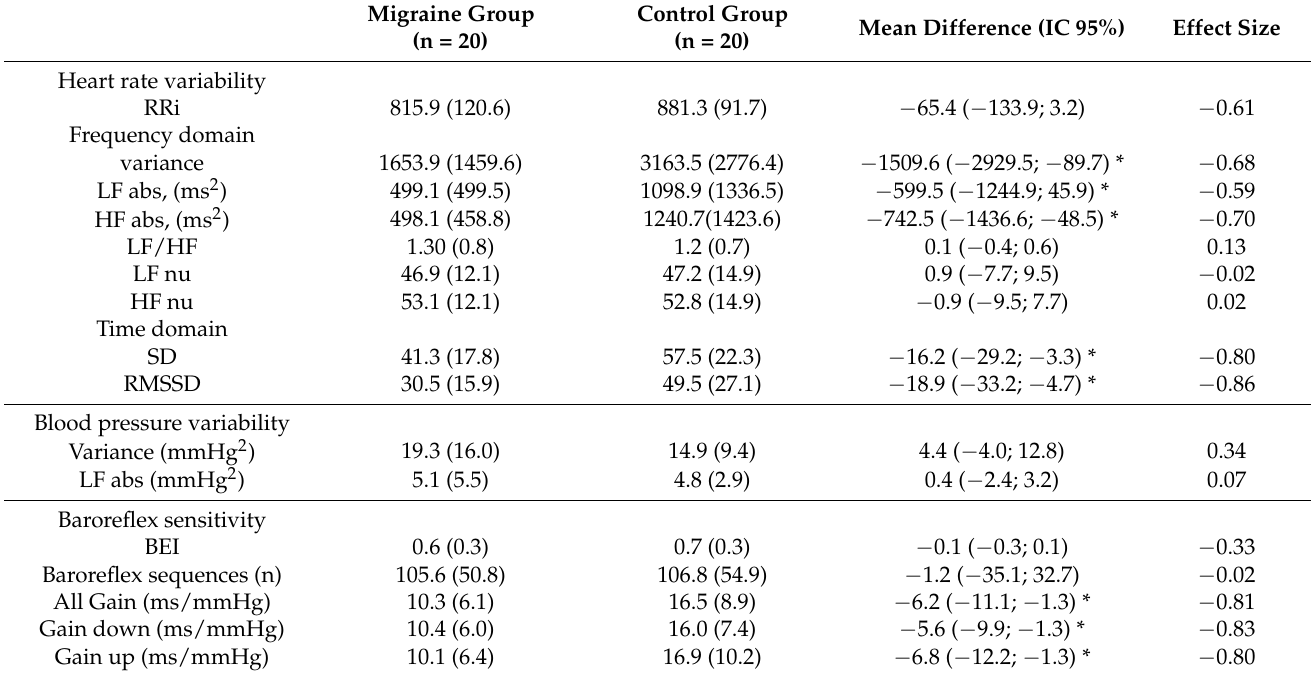
Table 2. Heart rate variability, blood pressure variability, and spontaneous baroreflex sensitivity in migraine and control